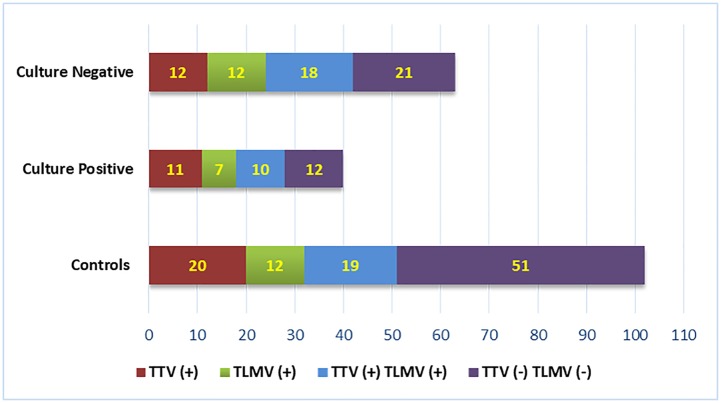
Histogram showing detection of TTV and / or TLMV DNA in vitreous of patients in the control group, culture positive and culture negative group.